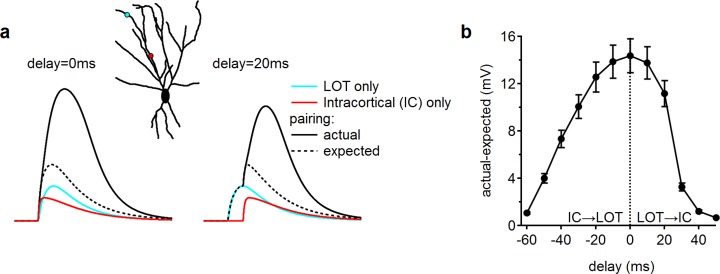
A wide integration window for a simulated pairing of LOT and IC inputs:(a) Example somatic EPSPs recorded following activation of a single distal input, representing LOT activation (cyan), a single proximal input within the intracortical (IC) layer (red) together with a paired activation of the two (solid black). Dotted black trace - the calculated expected linear summation of the individual EPSPs. Left, simultaneous stimulation; right, simulation with a 20 ms delay between LOT and IC input activation. Inset, input location. (b) The difference between the simulated paired peak somatic EPSP amplitudes to the expected values based on the linear EPSP shape summation as a function of the temporal difference between input activation. Synaptic intensity was set to 16 nS for the NMDAR and to 8 nS for the AMPAR conductance for both inputs. Negative delay represents initial activation of the IC input followed by the LOT input; in a positive delay, the temporal sequence is reversed.